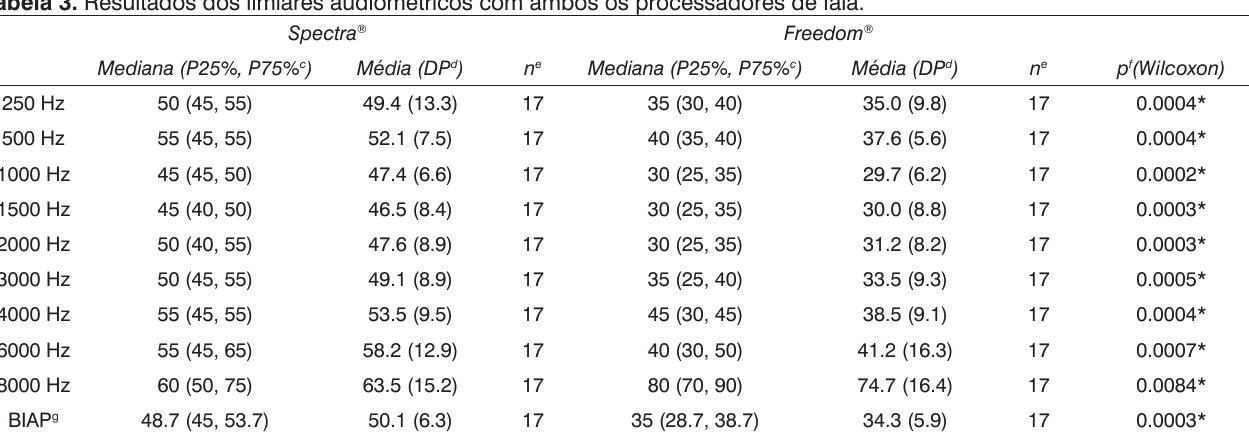
Otorrinolaringol.